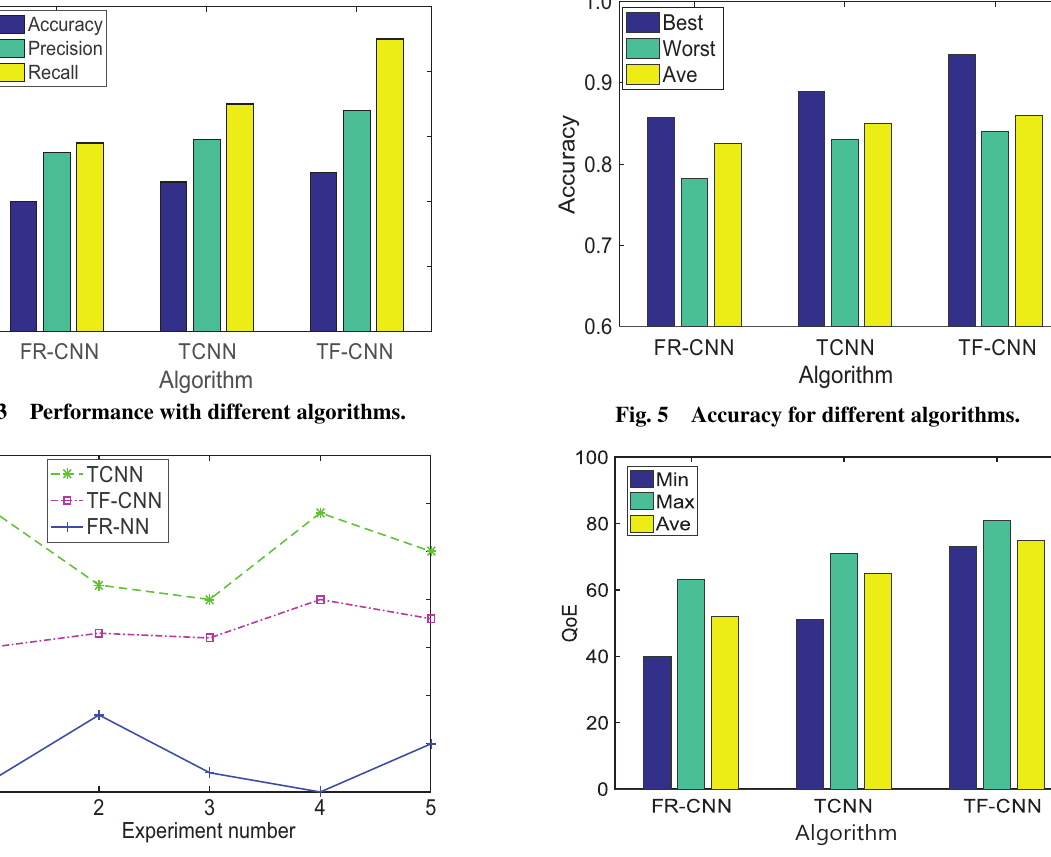
Fig. 4 Training time with different algorithms.